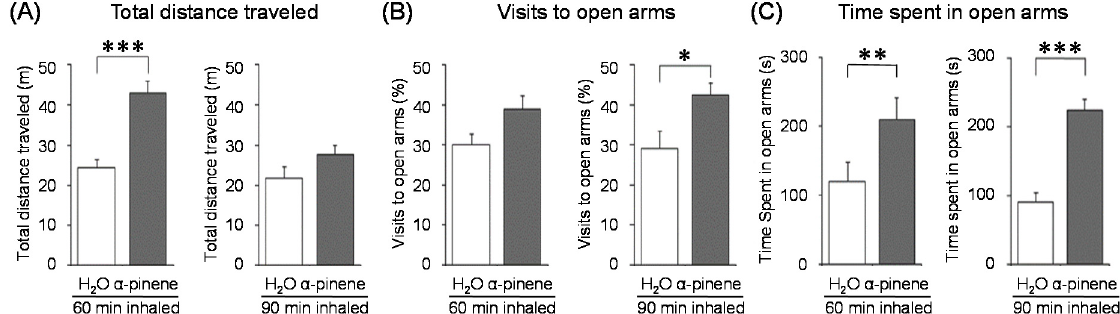
Figure 5. Effects of α -pinene on mouse behavior. Stressed mice were inhaled with distilled water or α -pinene for 60 or 90 min., and then an elevated plus-maze test was performed. ( A ): Total distance traveled (m). ( B ): Visits to open arms (%). ( C ): Time spent in open arms (sec). The results show means ± SEM (n = 5). * p < 0.05, ** p < 0.01, *** p < 0.001 (Student’s t -test). This figure is modified based on the original figure [103] with the copyright permission.